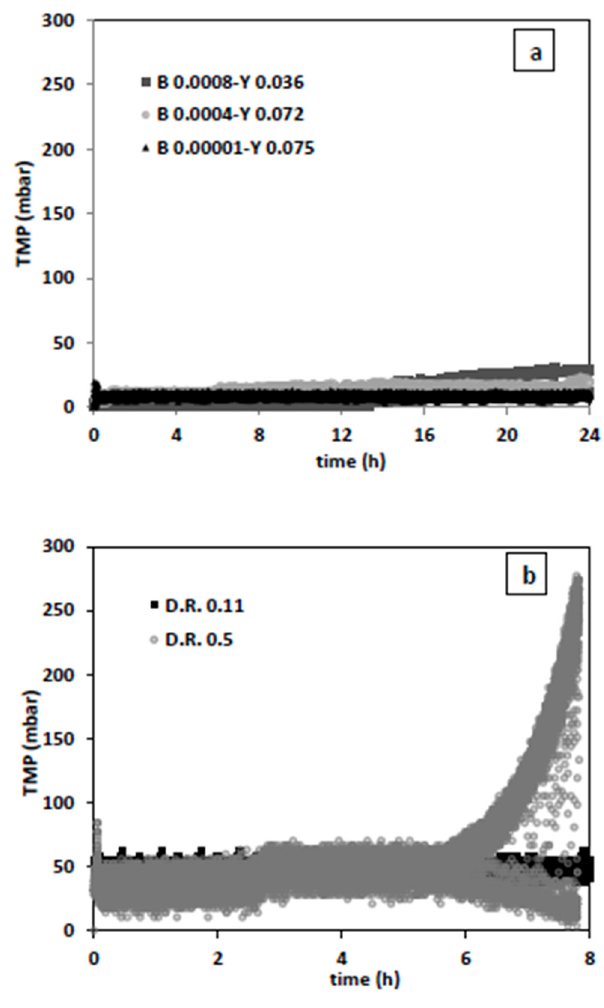
Figure 10. Changes in ( a ) TMP based on different starting inoculum size (dilution rate 0.11 1/h) and ( b ) TMP based on dilution rate with filtration in double panel.